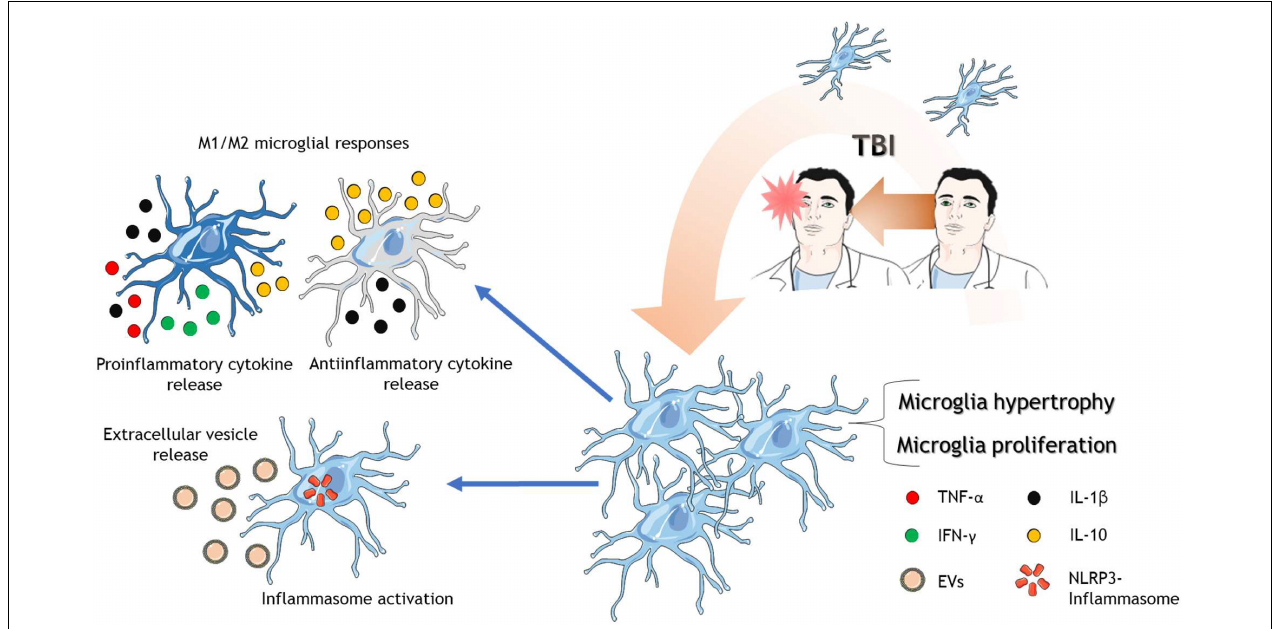
FIGURE 2 | Microglia in response to TBI. After TBI of different severities, microglia are activated where they proliferate, increase in size and complexity. There are reports that microglia polarize into possible phenotypes, M1 and M2. M1 microglia release mainly proinflammatory cytokines and the anti-inflammatory cytokine IL-10. On the other hand, M2 microglia release mainly anti-inflammatory cytokines and the proinflammatory cytokine IL-1 β . Microglia also activate the NLRP3-inflammasome protein complex and release extracellular vesicles to spread neuroinflammation. The cartoon was made using SERVIER Medical Art templates